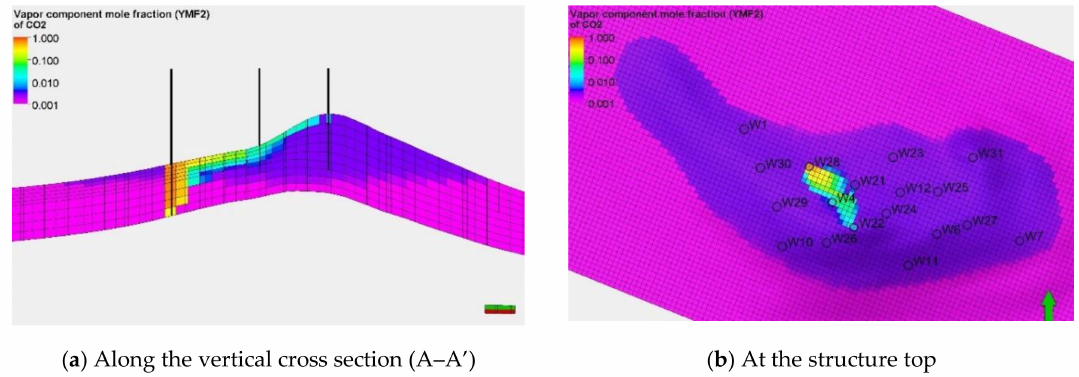
Figure 31. Distribution of CO 2 concentration in the gas phase in 2019.